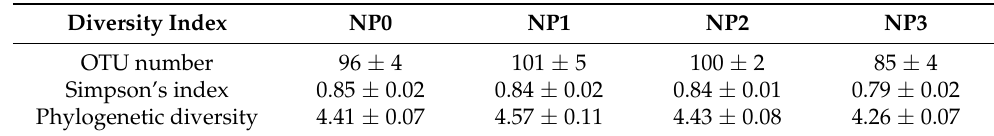
Figure 5. The linear discriminant analysis effect size (LEfSe) analysis of predicted microbial taxa in deficient-nitrogen-level (red) and sufficient-nitrogen-level (green) samples.